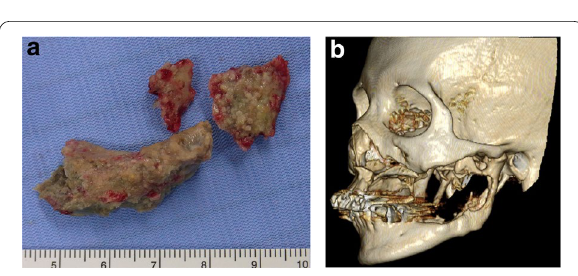
Fig. 4 a Surgical specimen. The specimen was diagnosed histologically as sequestrum. b 3D CT imaging findings on the first